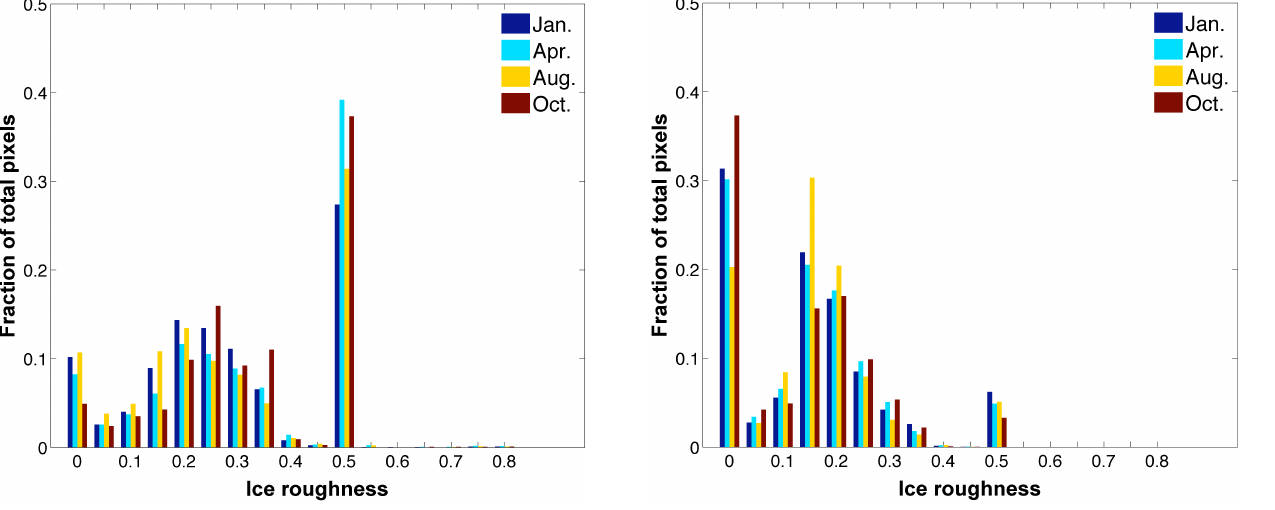
Fig. 7. As in Fig. 6 but for the tropics only. Fig. 8. As in Fig. 6 but for midlatitude regions